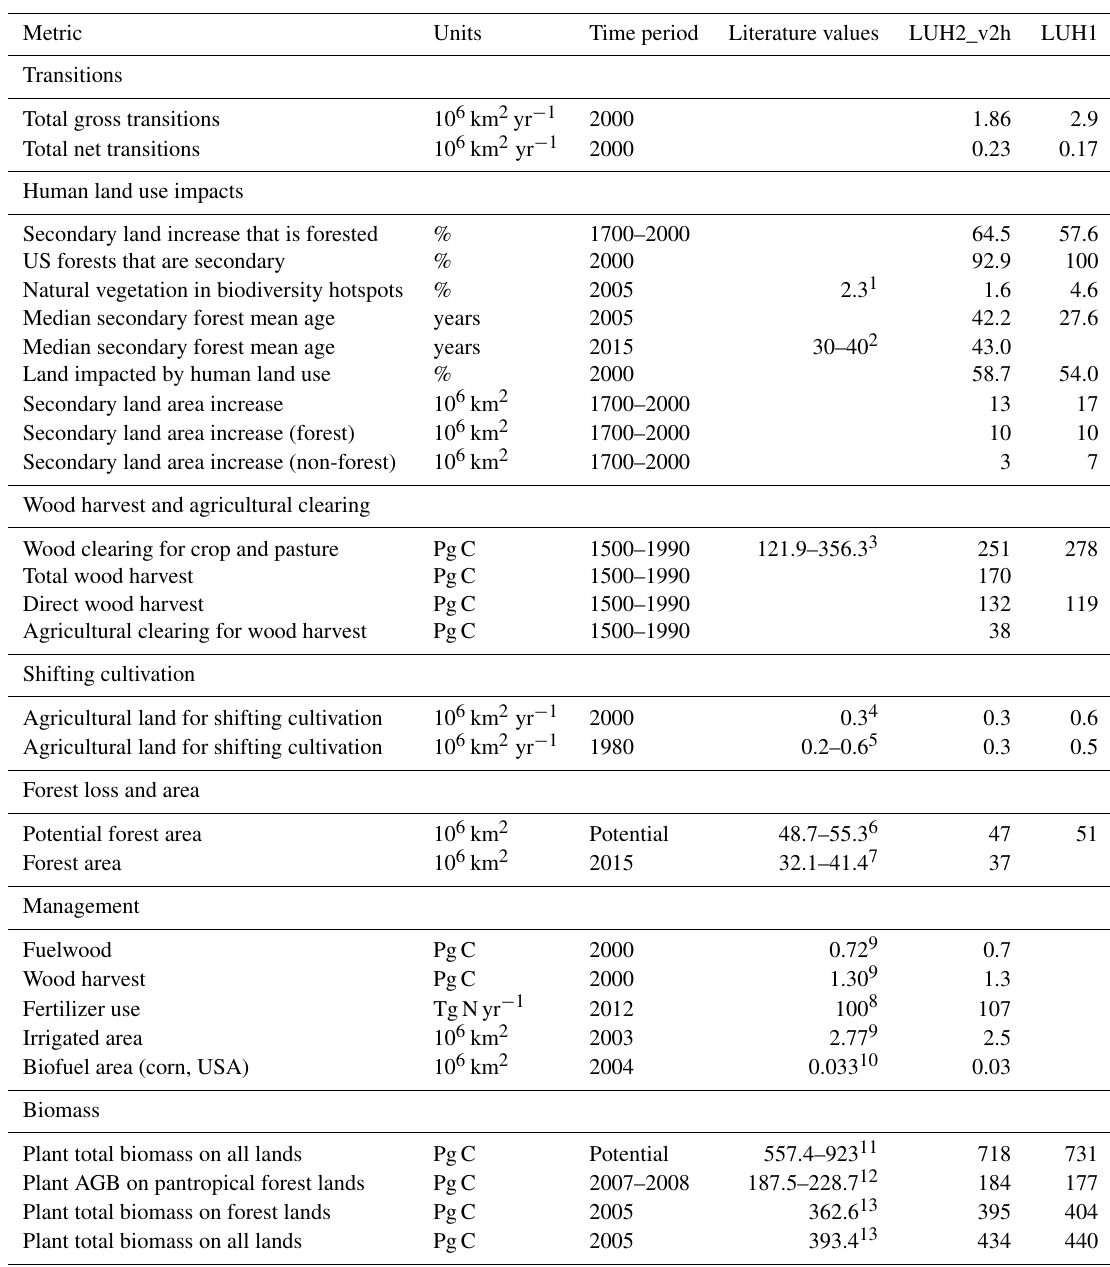
Table 3. Diagnostic table of historical data.